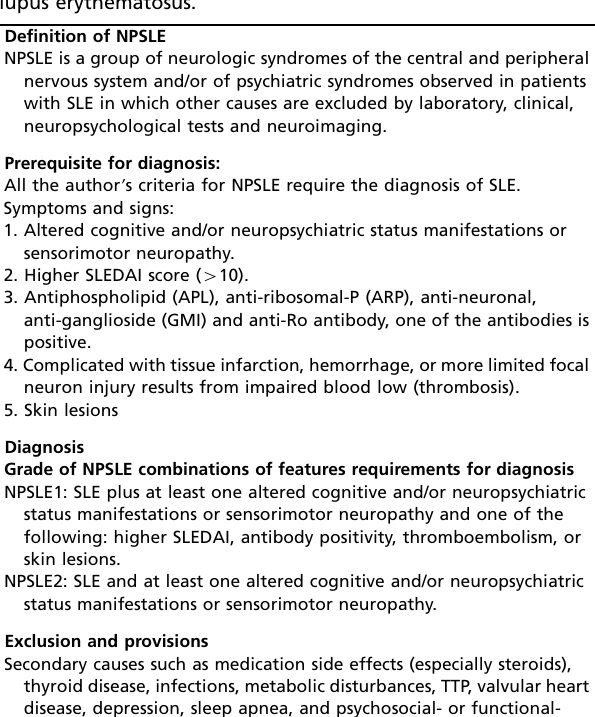
Table 2 - Definition and diagnostic criteria for neuropsychiatric lupus erythematosus.